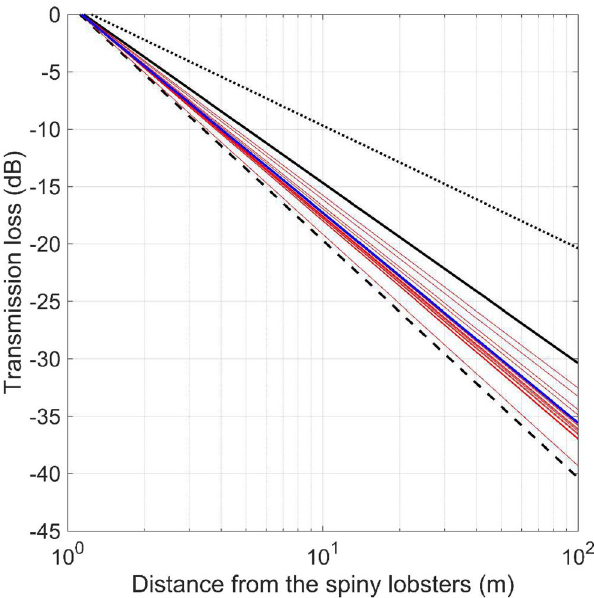
Figure 2. Transmission losses (TL) estimated for 19 spiny lobsters (red lines) based on the dataset SPL rms vs. distance, and the global fitted TL (blue line, a = 17.6). Black lines represent theoretical models of TL: dotted is cylindrical ( a = 10), continuous is practical ( a = 15), dashed is spherical ( a = kilometre scale under the theoretical ANL, with largest individuals being detected up to 1740 m (Table 1). Using an attenuated cylindrical loss model for TL (the least conservative), all spiny lobsters (except the very small ones) may be detectable at the kilometre scale under the theoretical low ANL, with largest spiny lobsters being detected up to 3610 m (Table 1).